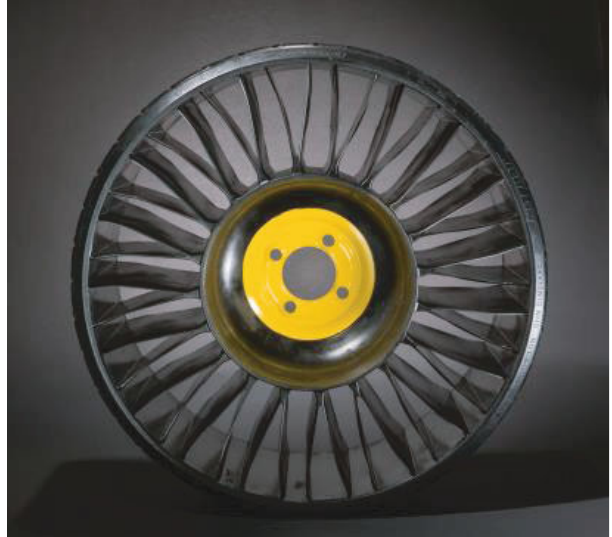
Figure 5: Early prototype of